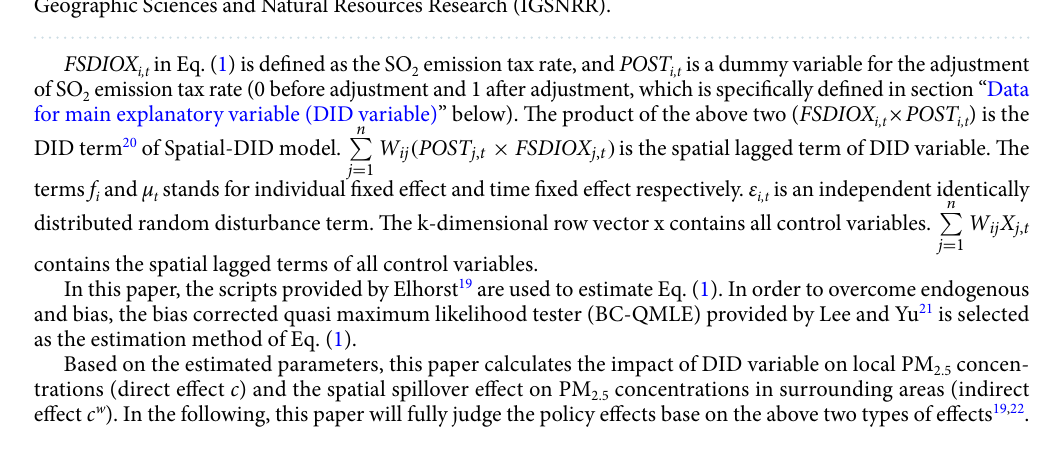
Figure 1. Adjustment of SO 2 emission tax rate in China. Note: The basic map resources come from Institute of Geographic Sciences and Natural Resources Research